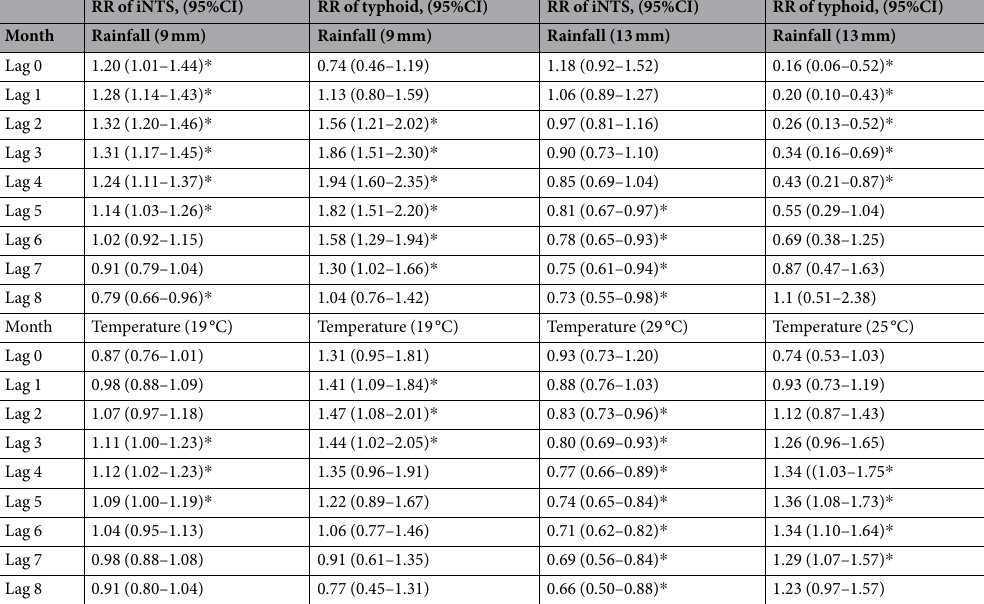
RR of iNTS, (95%CI)